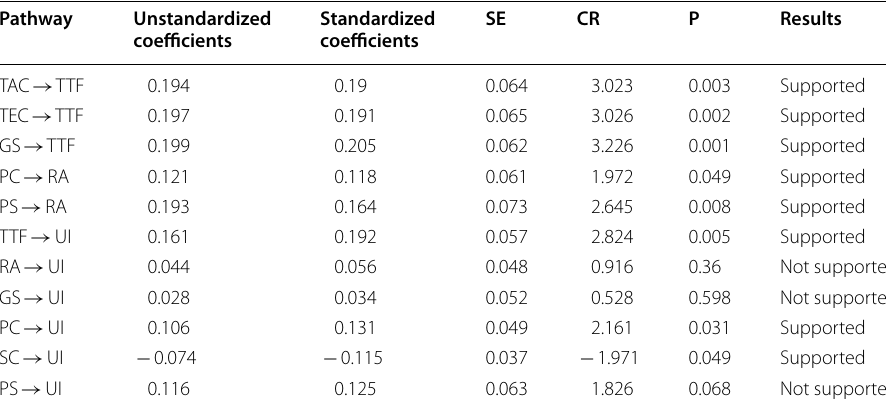
Table 8 Pathway analysis results